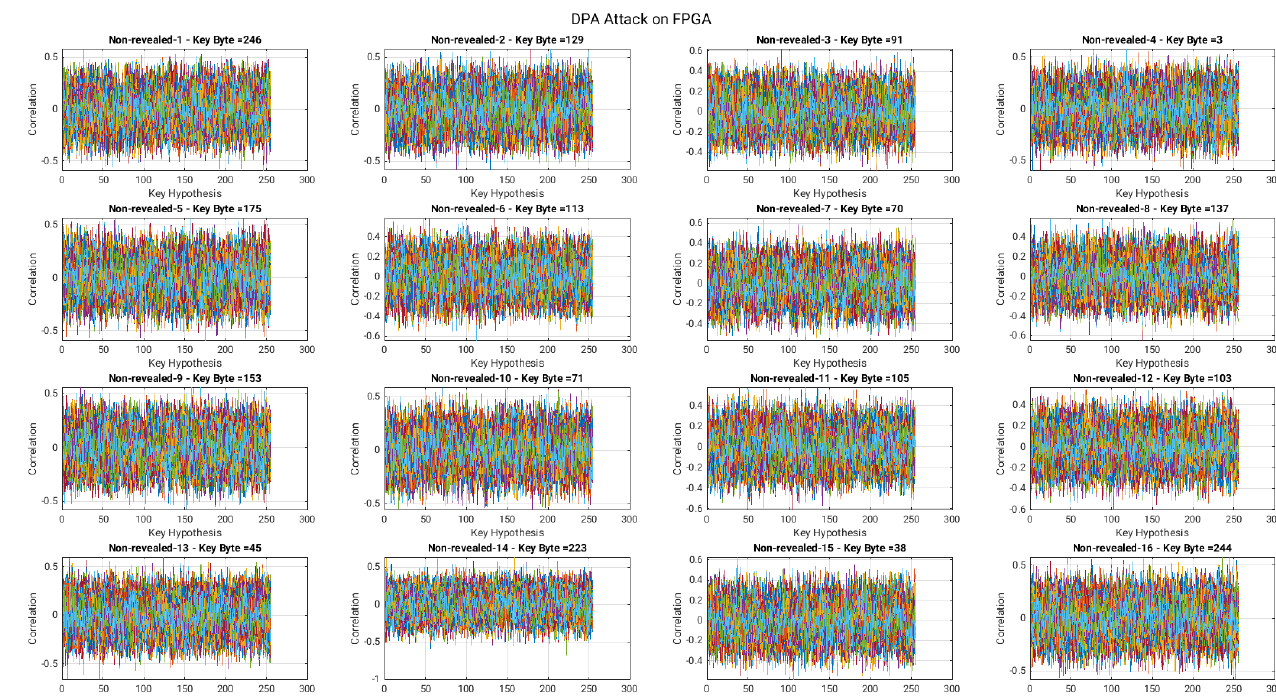
Figure A2. DPA attack on AES with the inclusion of our proposed